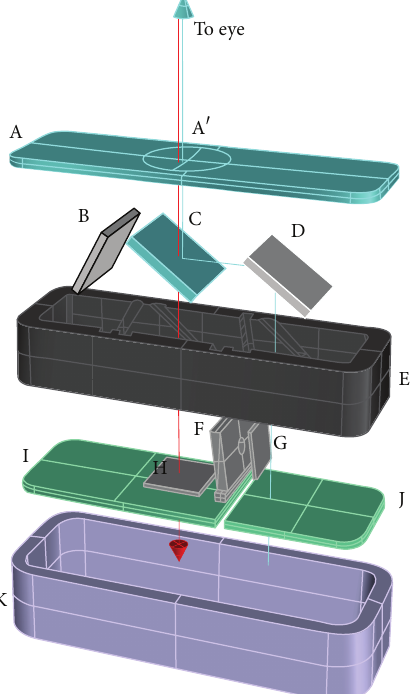
Figure 1: Exploded view of the D-Eye module (angles and dis- tances between components are approximated). Retinal images are acquired using coaxial illumination and imaging paths thanks to a beam splitter (C). The blue arrow depicts the path of the light; red arrow depicts the path of fundus imaging. Device components are glass platelet (A) with imprinted negative lens (A 󸀠 ), photo- absorbing wall (B), beam splitter (C), mirror (D), plastic case (E), diaphragm (F), polarized filters (G, H), flash and camera glass (J, I), and magnetic external ring (K).